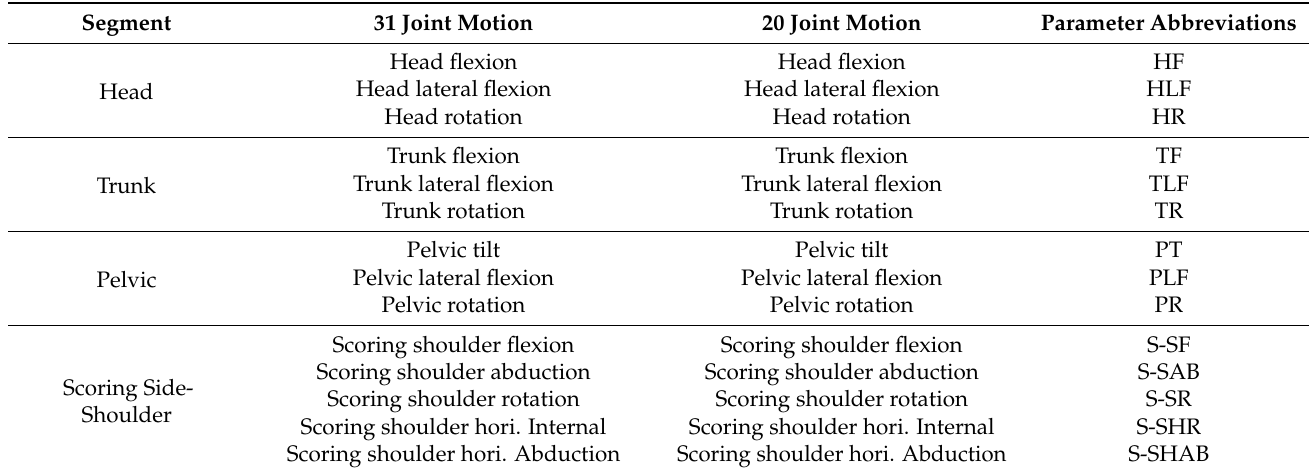
Figure 1. The placement location of the 11 sensors. Table 1. The joint motion measured by the